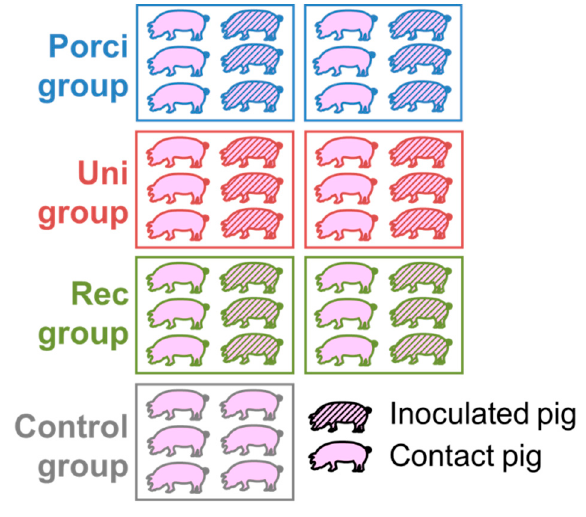
Figure 1. Experimental design.